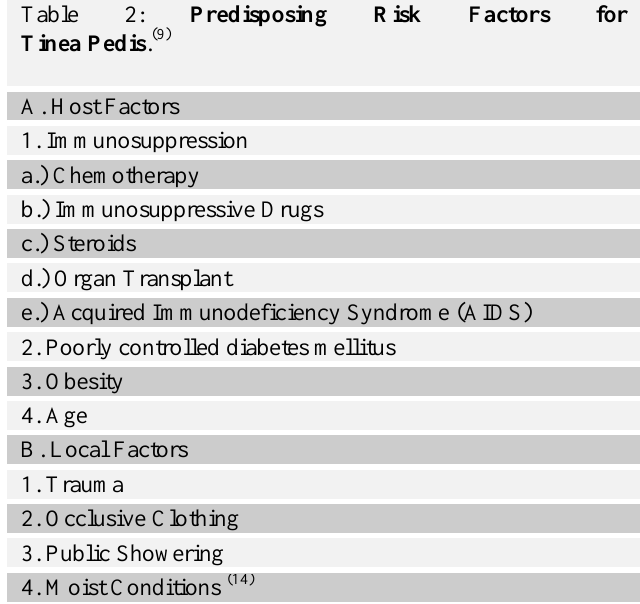
2: Predisposing Risk Factors